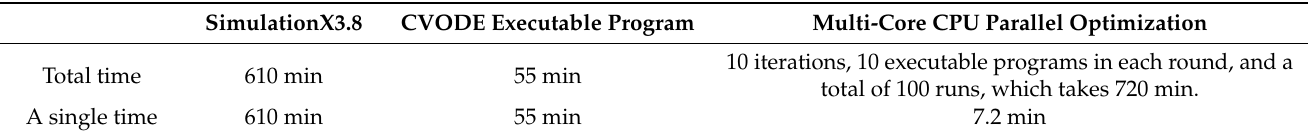
Table 4. Simulation time